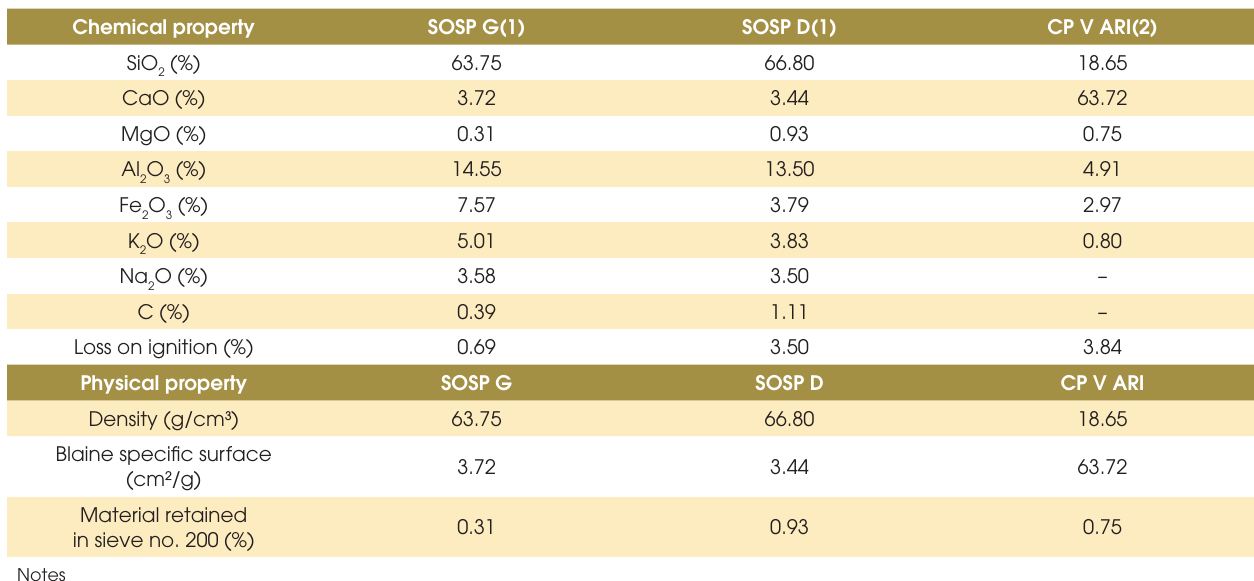
Table 1 – Chemical composition and physical properties of the wastes and Portland cement Chemical